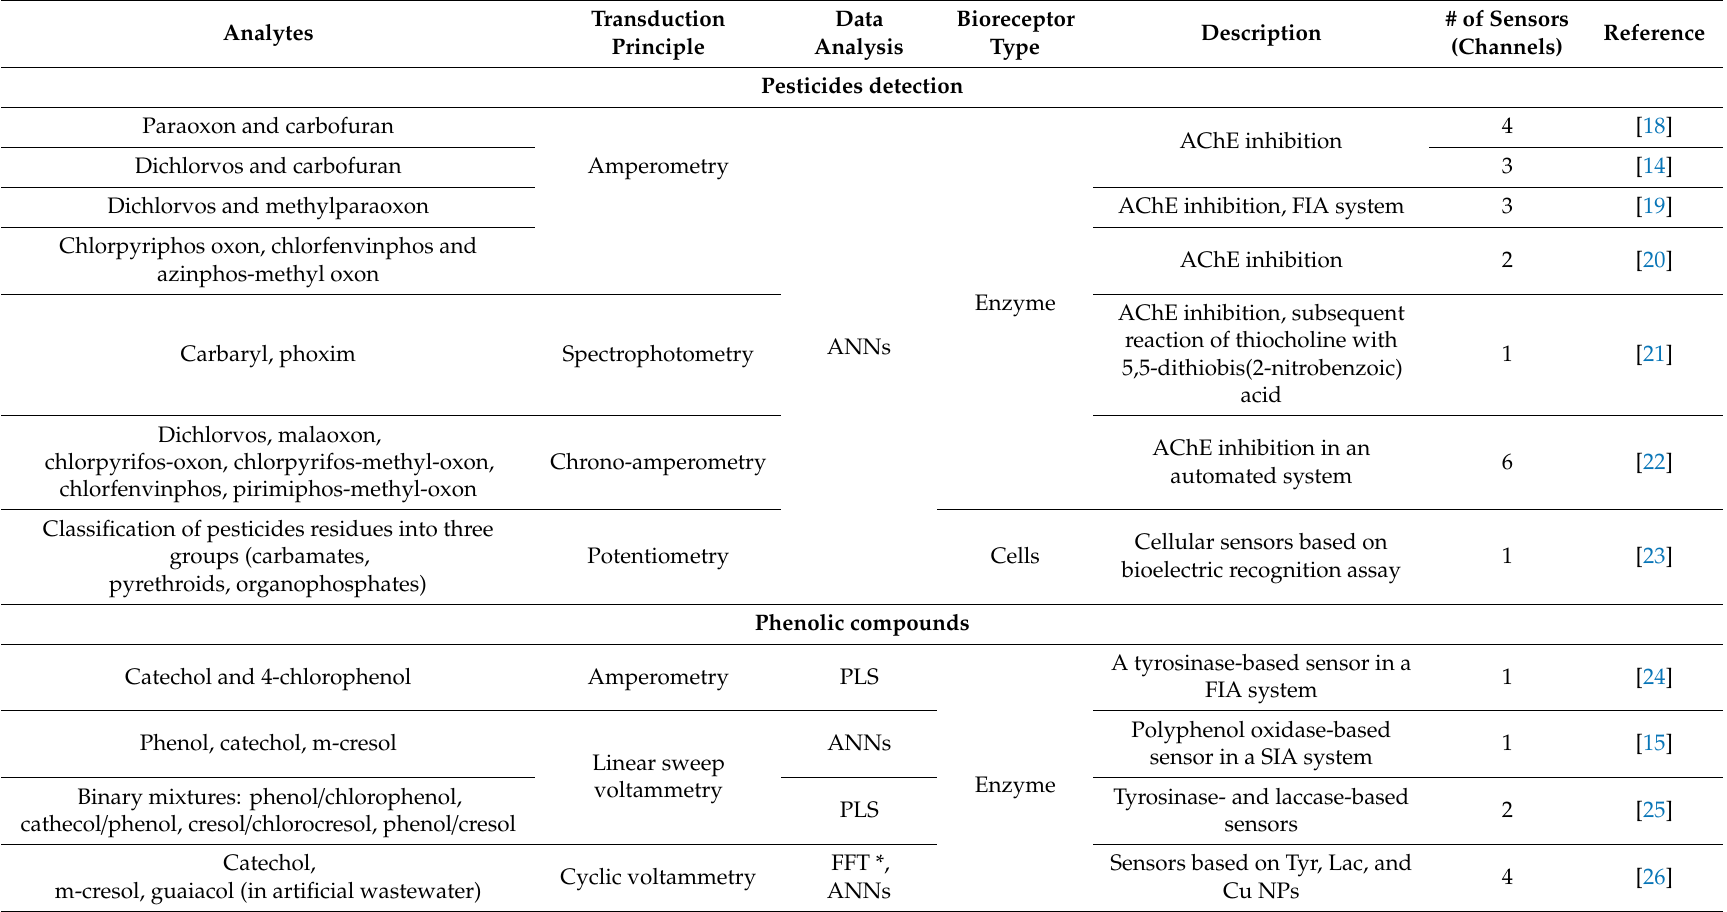
Table 1. Relevant examples of biosensors and bioelectronic tongues for the water